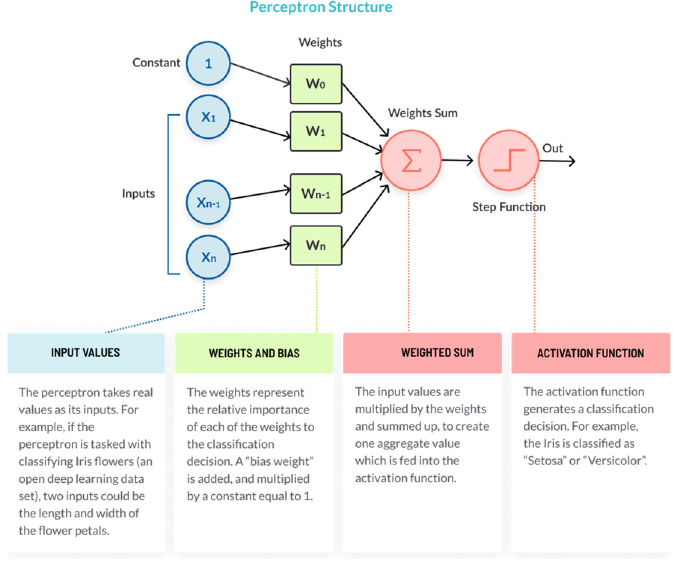
Figure 3. Perceptron structure.